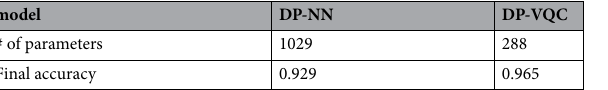
Table 4. Results from binary MNIST classification for a ( 0.406, 10 − (DP-NN) and VQC